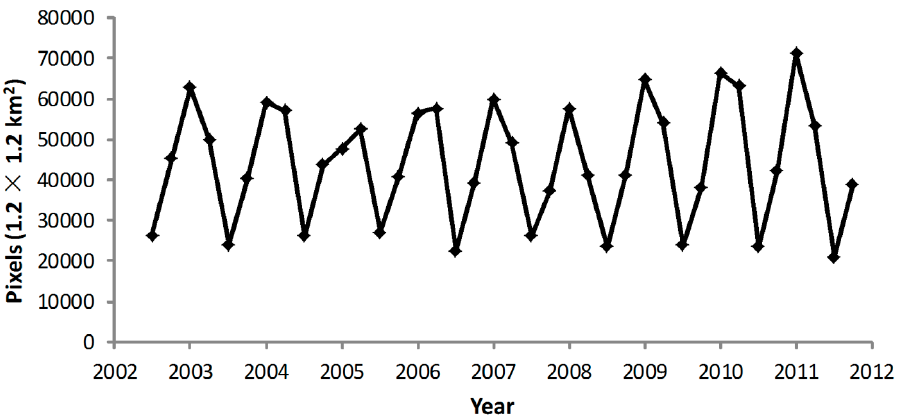
Figure 12. Seasonal frequency distribution of the Class E area in Jiangsu shoal between 31°N–35°N over the entire MERIS archive from 2002 to 2012.